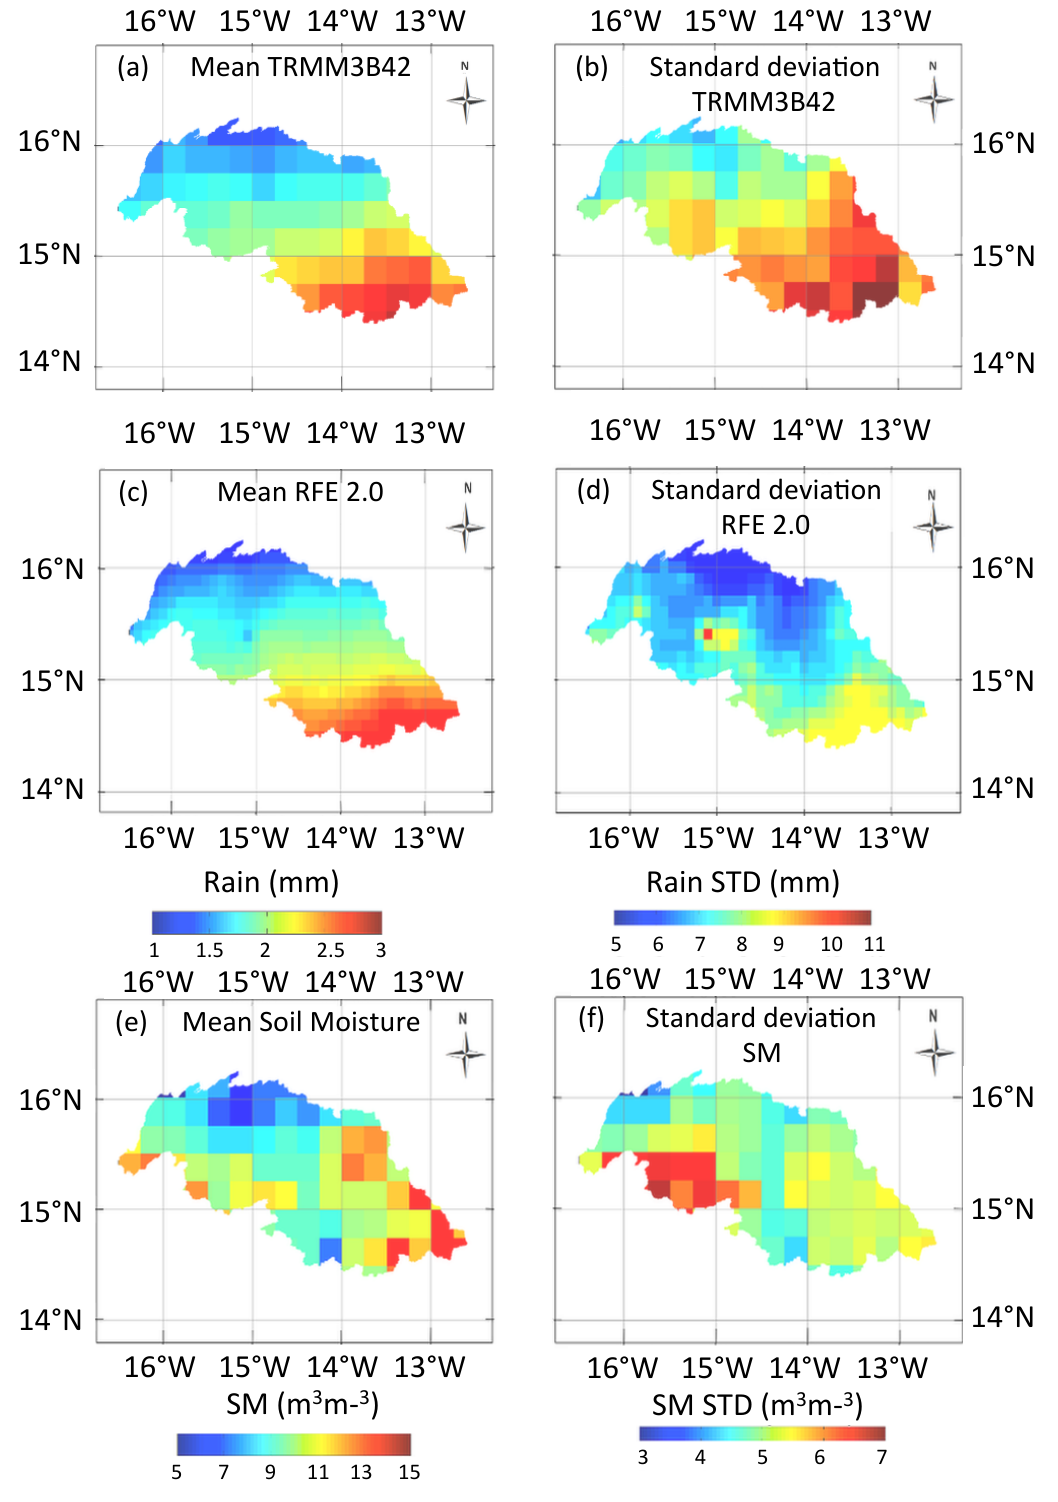
Figure 3. Spatial variations of rainy season rainfall ( i.e. , for months June through September) from 2000 to 2010, ( a ) and ( b ) show 11-year average seasonal rainfall and the variations of the standard deviation (STD) from TRMM3B42, ( c ) and ( d ) 10-year average and the STD variations for RFE 2.0, ( e ) and ( f ) 11-year average and the STD variations for soil